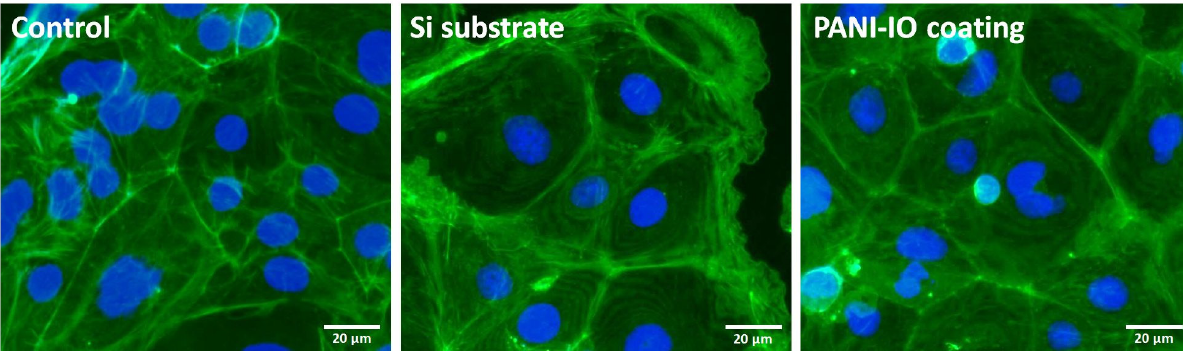
Figure 9. Fluorescence labeling of F-actin cytoskeleton in Caco-2 cells cultured on Si substrate and PANI-IO coating for 24 h. Green fluorescence indicates F-actin filaments staining by Alexa Fluor™ 488 phalloidin, and blue fluorescence is for nuclei (Hoechst). Control represents cells cultured in the absence of substrates. Magnification: 10×. Scale bar: 20 µm.